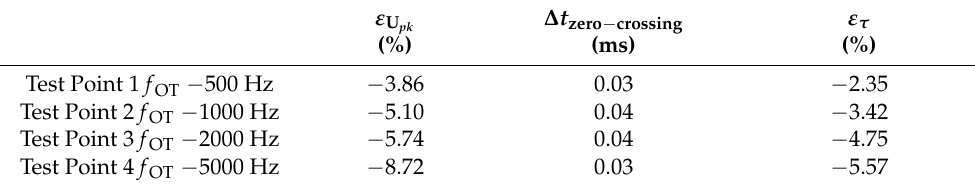
Table 15. LPVT PIs results under oscillatory transient